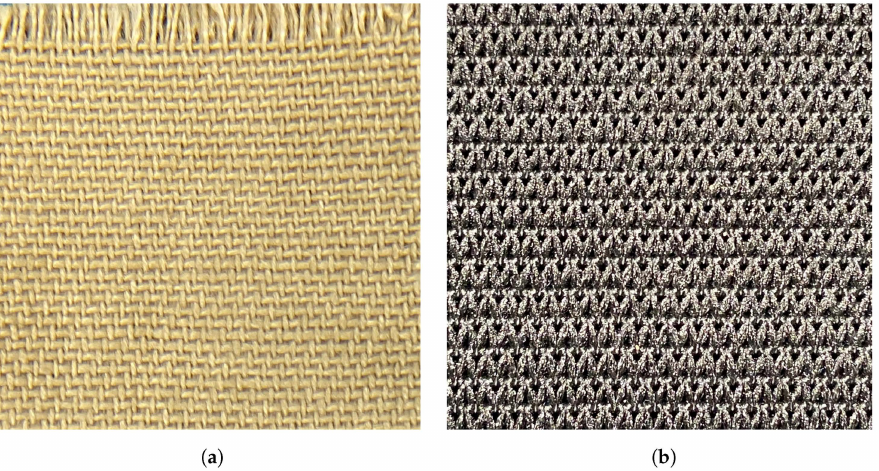
Figure 4. Examples of textile structures. ( a ) A close up view of a weaved structure. ( b ) A close up view of a knitted